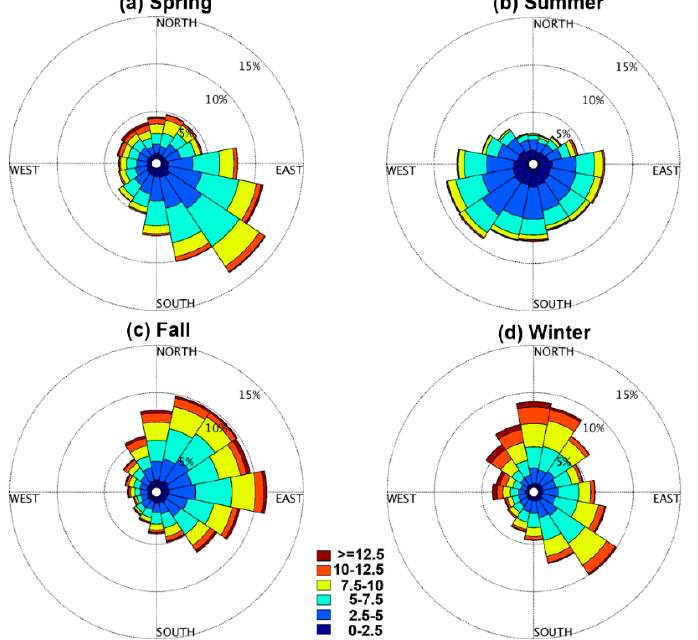
Figure 9. Wind rose diagrams (Unit: m/s) at buoy station 42040 in spring ( a ), summer ( b ), fall ( c ), and winter ( d ). (Spring: March, April, and May; Summer: June, July, and August; Fall: September, October, and November; Winter: December, January, and February).